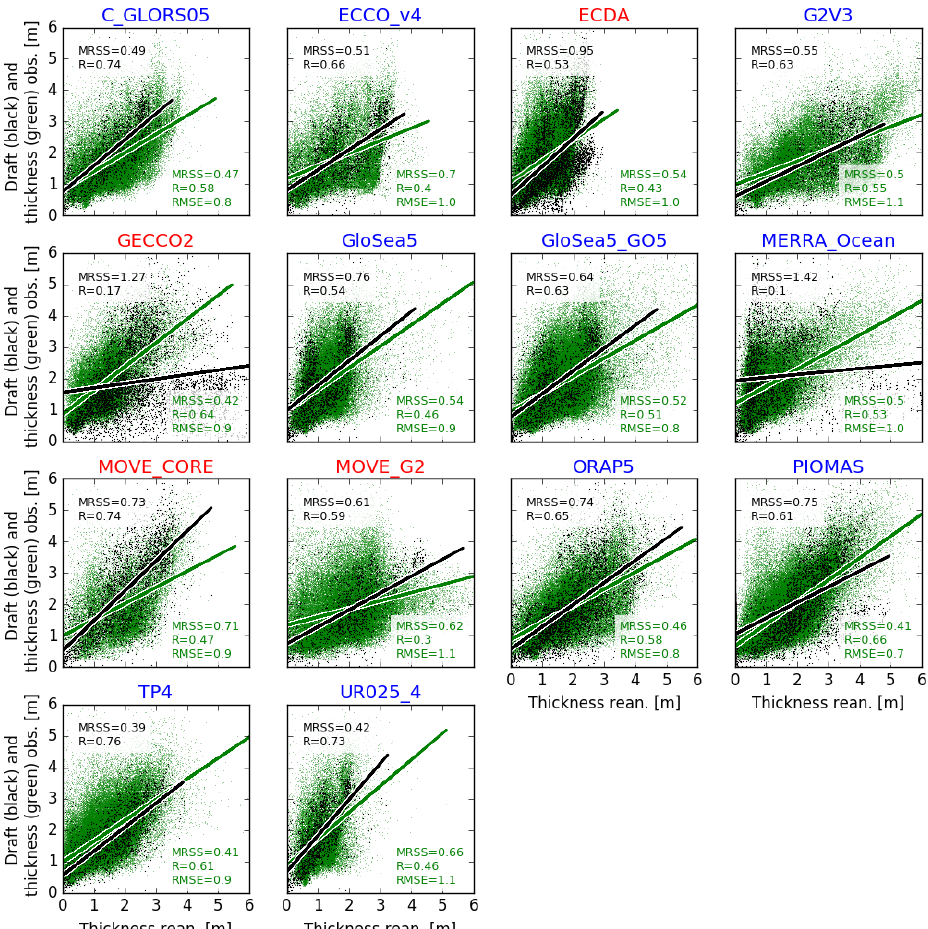
Figure 4. Comparison between sea ice thickness from reanalyses and sea ice thickness (green points) or draft (black points) from observa- tional datasets. The lines represent the linear fits having the reanalysis as the predictor and the observations as predicted variables. The mean residual sum of squares (MRSS) from the fit, the correlation coefficient ( R ), and the root mean square error (RMSE) are also displayed for each comparison. RMSE is calculated only when comparing SIT from both sources (green) but not when comparing SIT and draft (black). Reanalyses labeled in blue and red highlight whether the datasets were built with or without sea ice data assimilation,